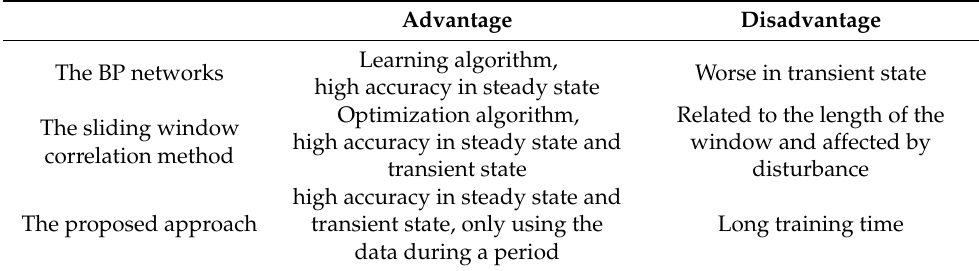
Table 6. The comparisons of three